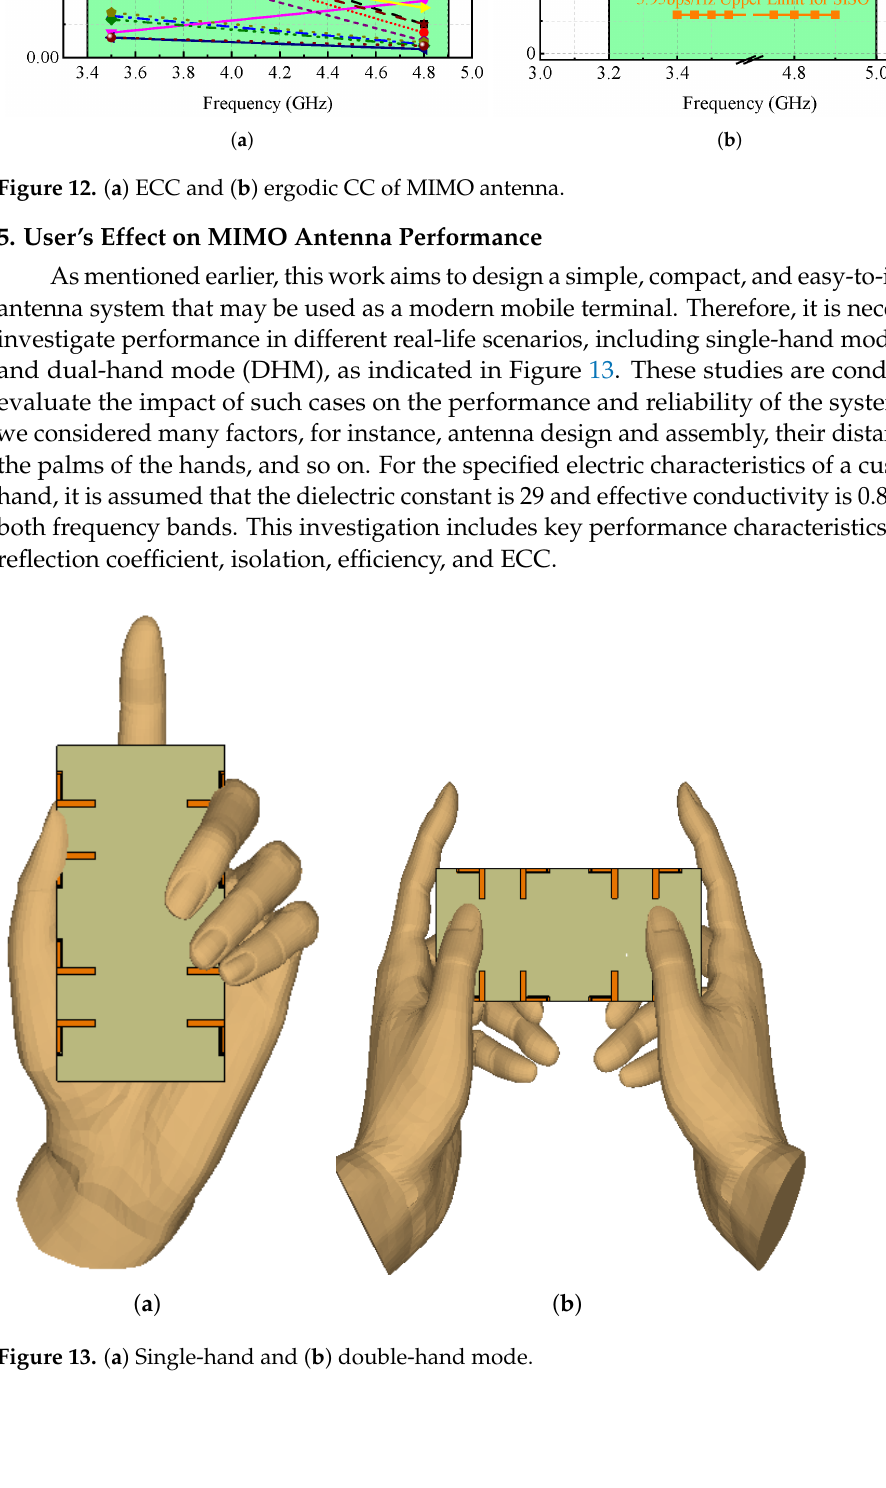
Figure 12. (a) ECC and (b) ergodic CC of MIMO antenna.